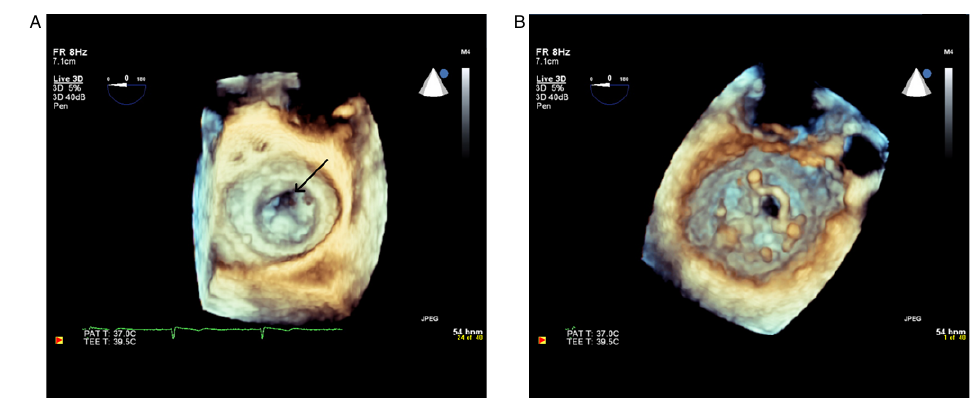
Figure. 9 Dysfunctional bioprosthetic valve showing opening of only one leaflet (arrow) from left atrial view (A) and from the left ventricular view (B). identifying the spatial geometry of the pathologic lesions, demonstrating asymmetry in leaflet tissue and the detection of interscallop clefts. The images facilitate demonstration and communication in regards to pathologic lesions between surgeons and